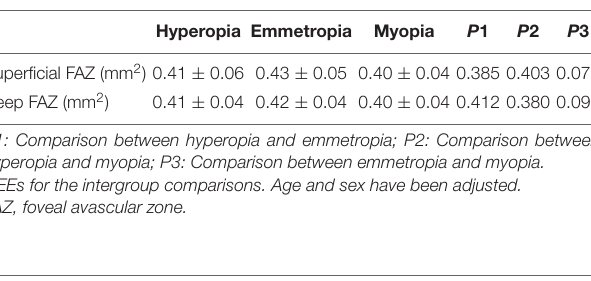
Frontiers in Medicine |